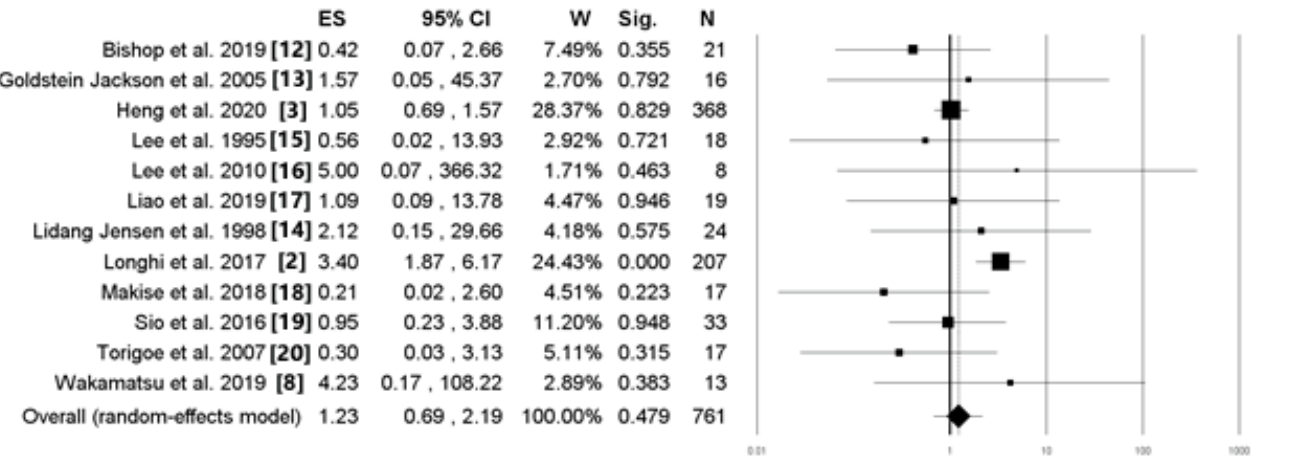
Figure 4. A forest plot shows the proportion of patients in the surgery combined with adjuvant chemotherapy and surgery groups who were disease ‐ free for 5 years in the various studies. (ES: effect size (odds ratio); CI: confidence interval; W: weight; Sig: significance ( p ‐ value); N: total sample